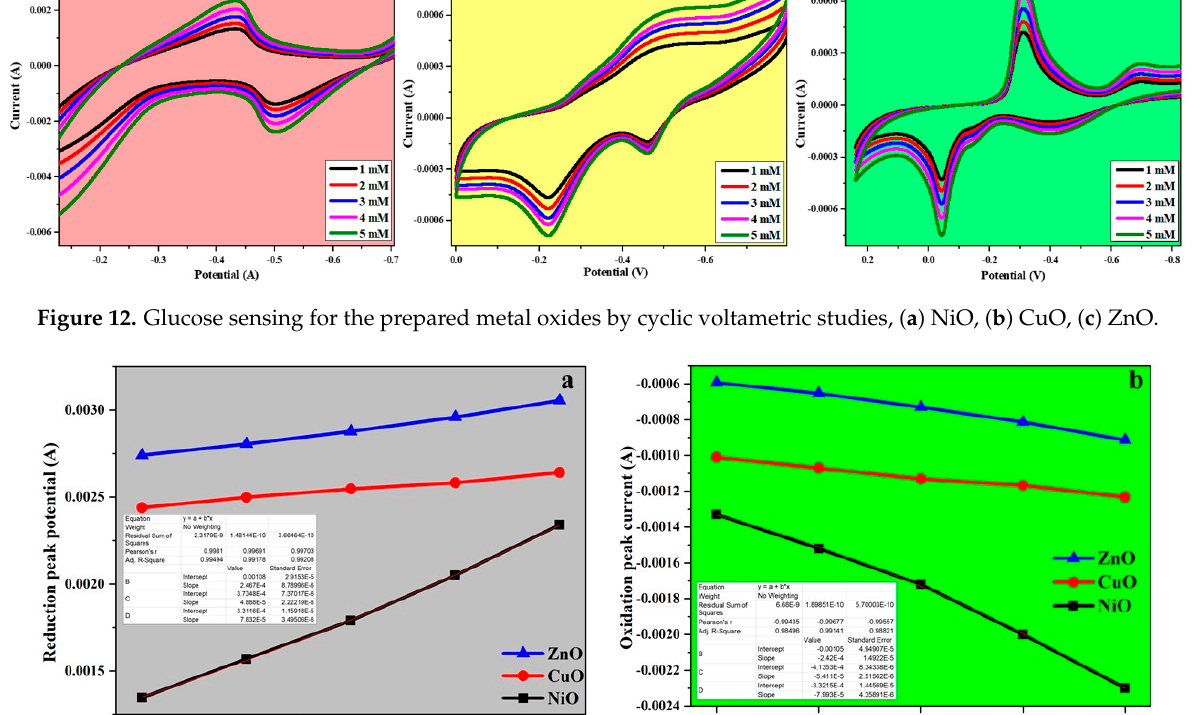
response vs. Glucose concentration with fitted data.